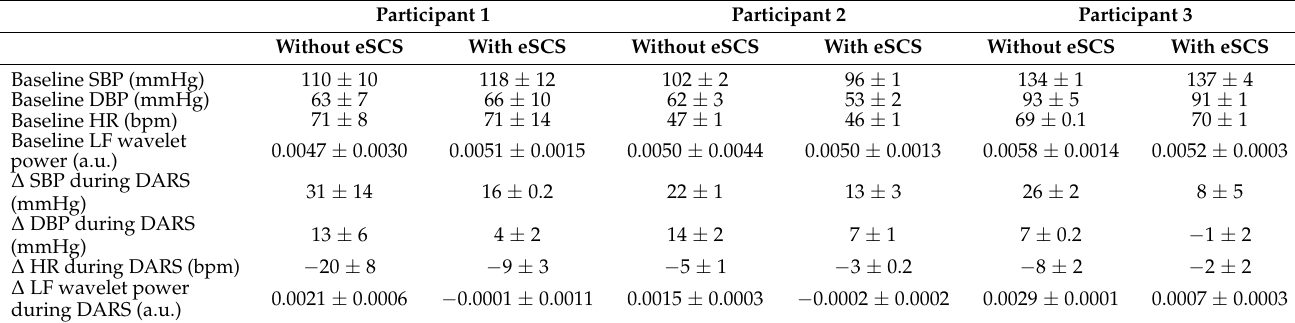
Table 1. Cardiovascular responses at rest (supine) and in response to DARS, with and without eSCS in individuals with SCI.